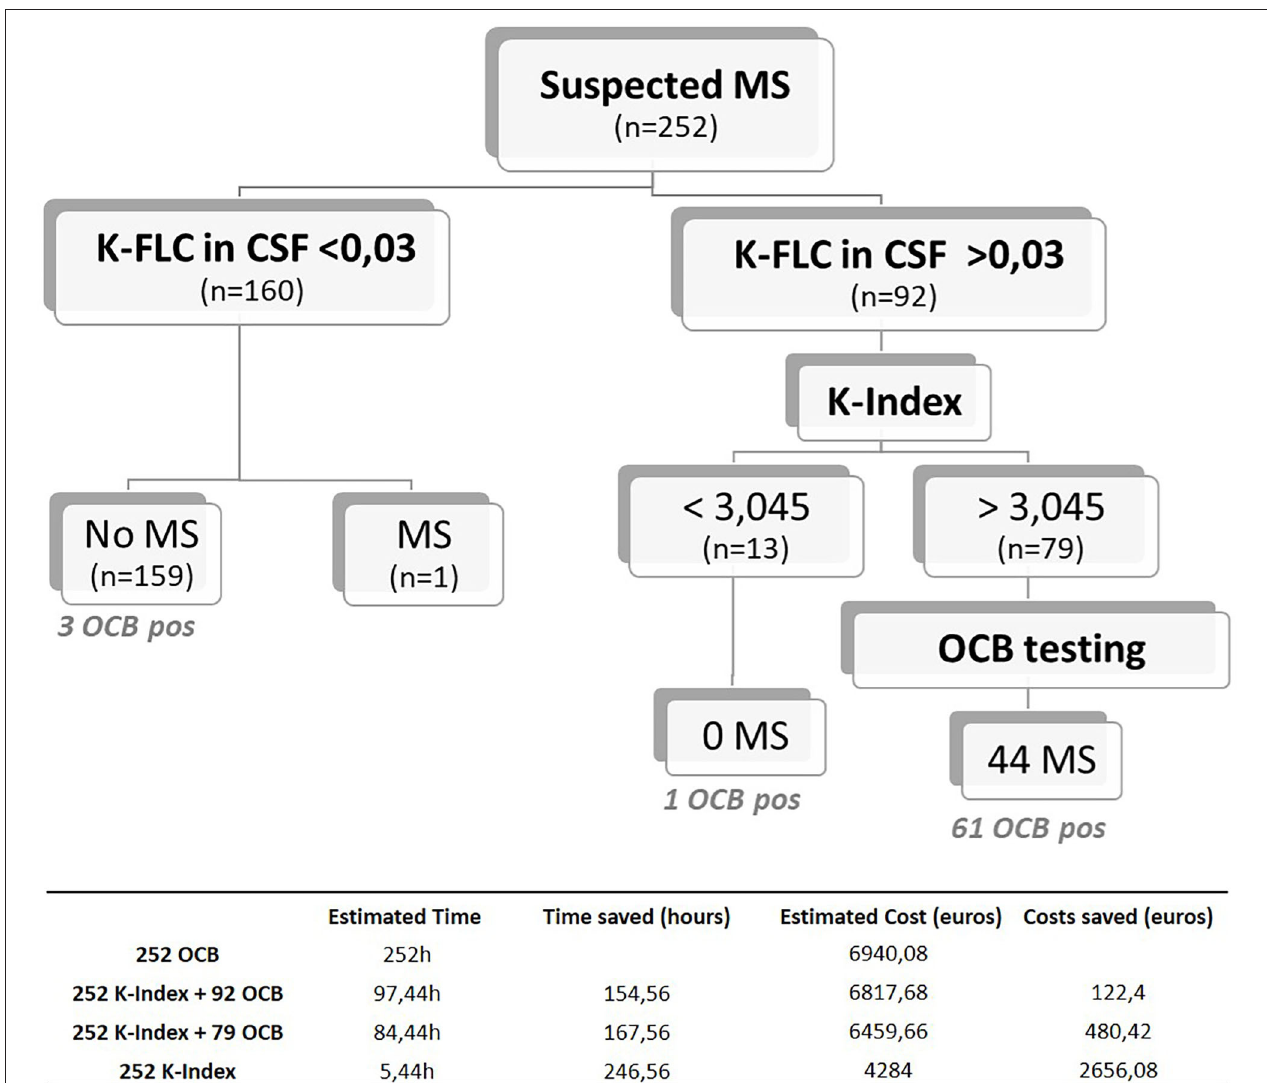
FIGURE 4 | Proposed screening algorithm for patients with suspected MS, based on the K-FLC levels in CSF measured in an Optilite system, the K-Index 3.045 optimal threshold, and OCB testing. Estimated time and cost breakdown included on the table below. MS, multiple sclerosis; K-FLC, kappa free light chain; CSF, cerebrospinal fluid; K-Index, kappa index; OCB, oligoclonal